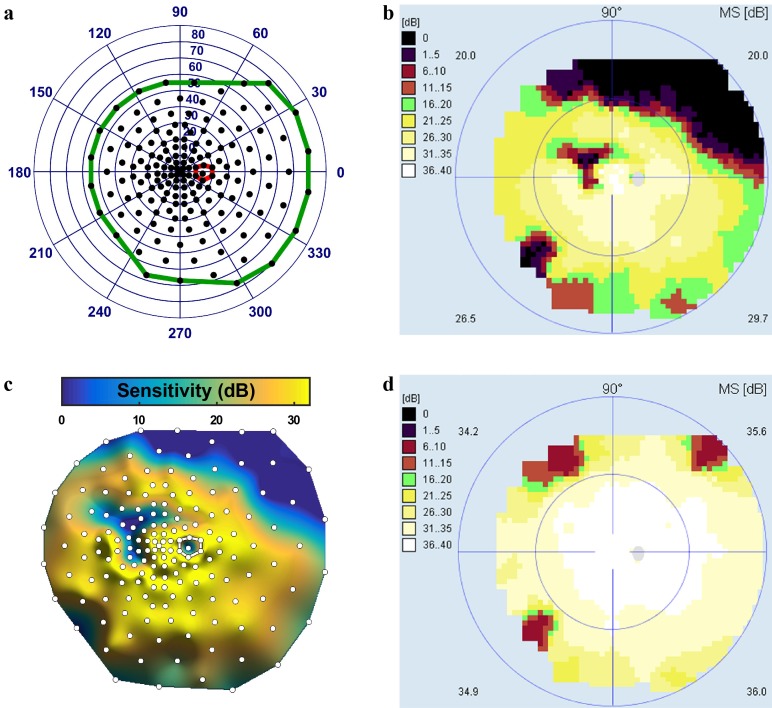
SAP acquisition and HOV representation.(a) Right-eye full-field 164-point SAP test grid pattern, which spans 140° horizontally and 130° vertically. The expected location of the natural blind spot is outlined in red. (b) Example Octopus perimeter sensitivity map for one participant. (c) Top-down view of the interpolated HOV surface for this participant, with the test grid locations shown as white circles. The surface height represents the visual field sensitivity. (d) Octopus sensitivity map for a healthy normal, for comparison.